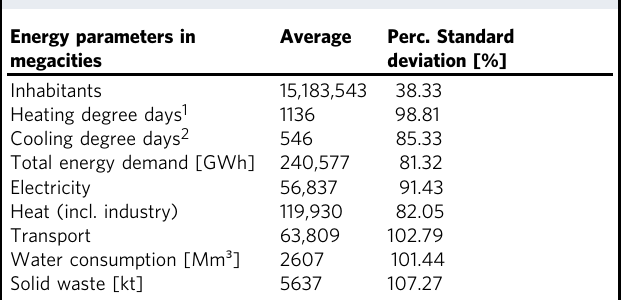
Table 2 Average energy parameters in megacities, from 2001 to 2011 23